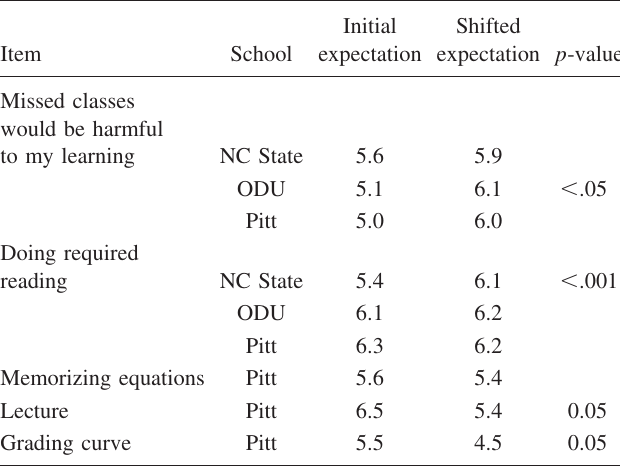
TABLE I. Sample items demonstrating shifts in student